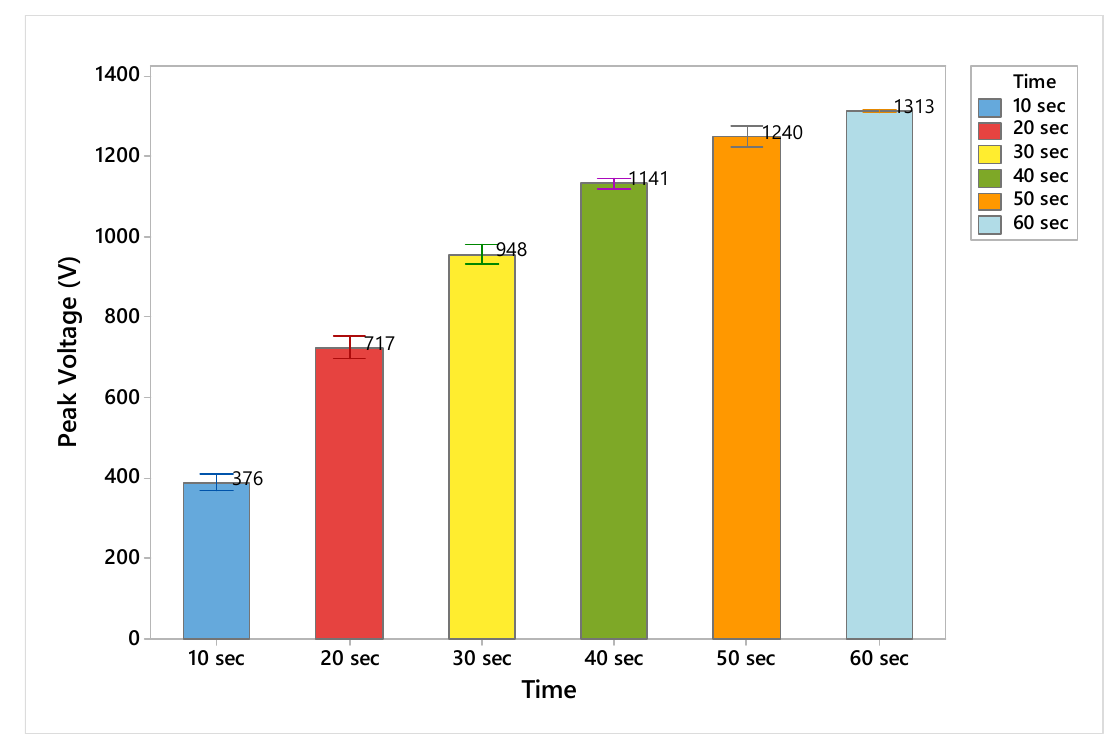
Figure 9. Effect of testing duration on the electrostatic charge generation.